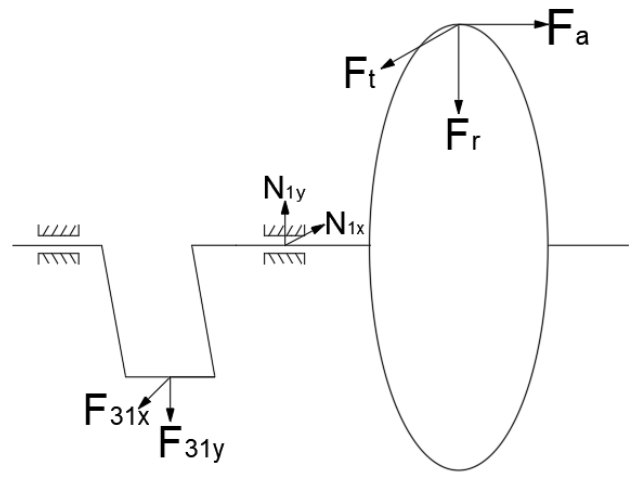
Figure 8. Diagram of force analysis on support 1 of the crankshaft.